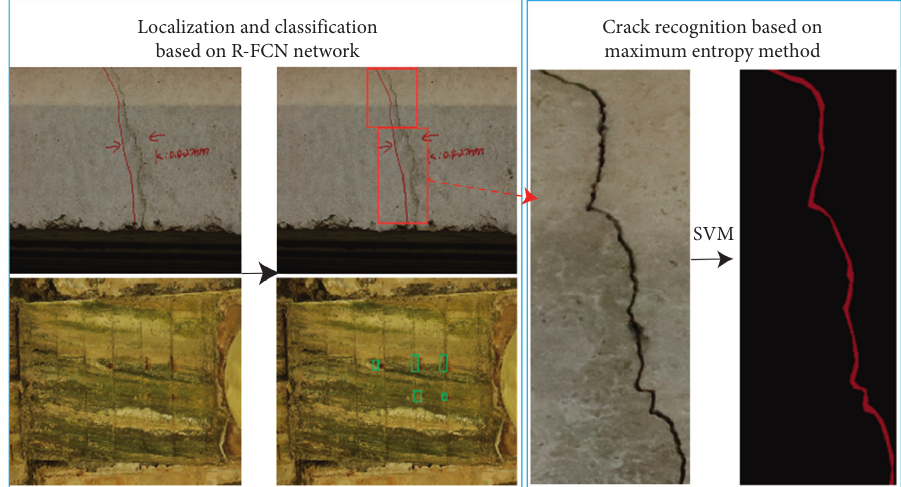
Figure 9: Recognition framework for bridge defects.